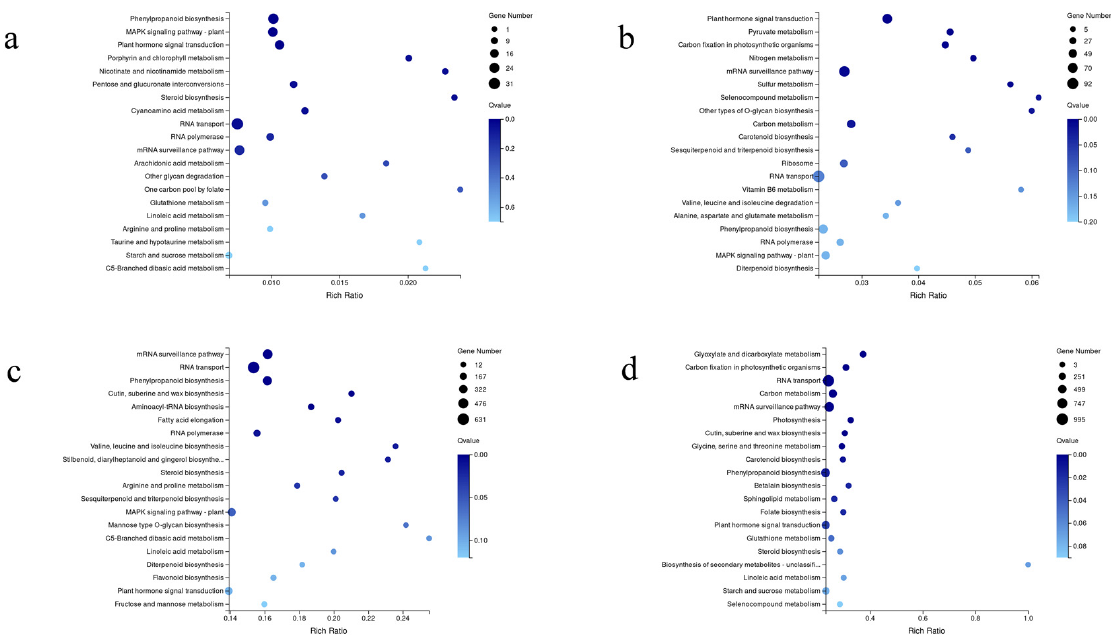
Figure 4. Summary statistics for Kyoto Encyclopedia of Genes and Genomes (KEGG) pathway enrichment of differential expression genes. The vertical axis shows the pathway, and the horizontal axis shows the enrichment factor. The size of the dot represents the number of DEGs in the pathway. Dot color corresponds to the range of Q-value: ( a ) CKD2/DD2; ( b ) CKL3/DL3; ( c ) CKD2/CKL3, and ( d ) DD2/DL3.